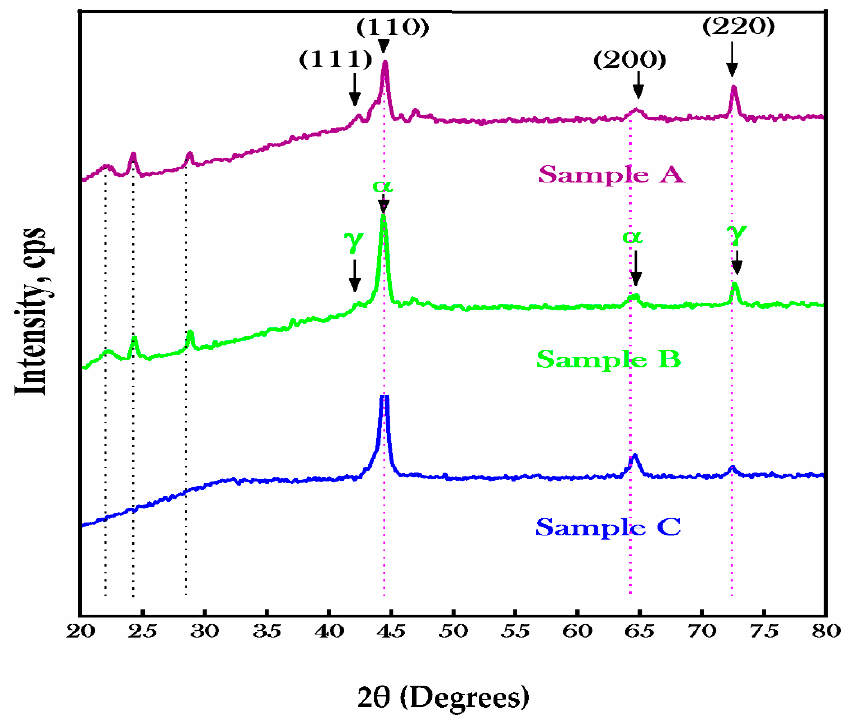
Figure 3. The X-ray diffraction pattern of the Sample A alloy, Sample B alloy and Sample C alloy after complete heat treatment showing the single solid solution of the α -phase accompanied by some unwanted γ